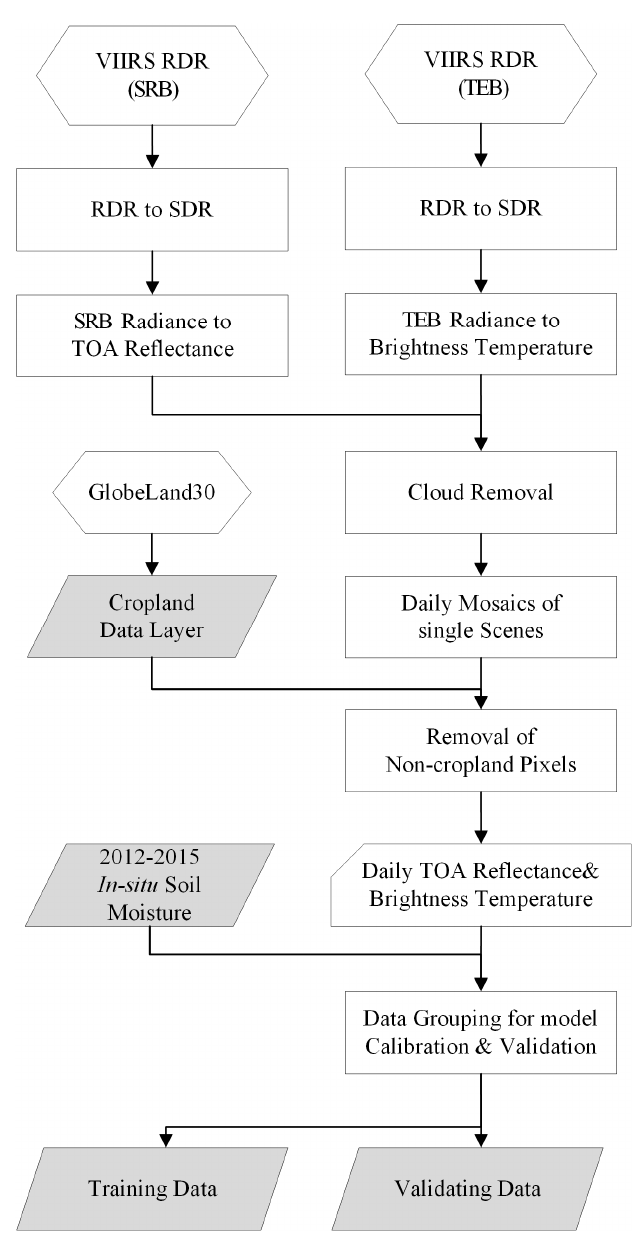
Figure 2. The procedure of the model input calculation.